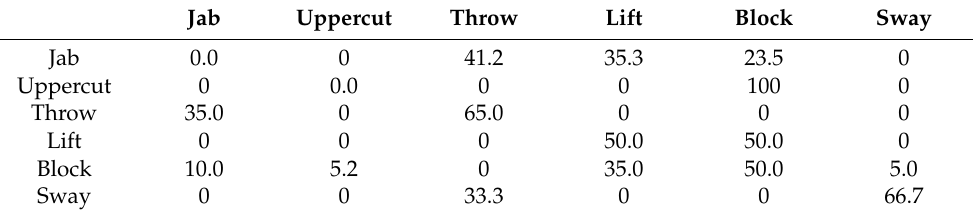
Table 5. Confusion matrix (in %) for validation set accuracy of Right Hand,